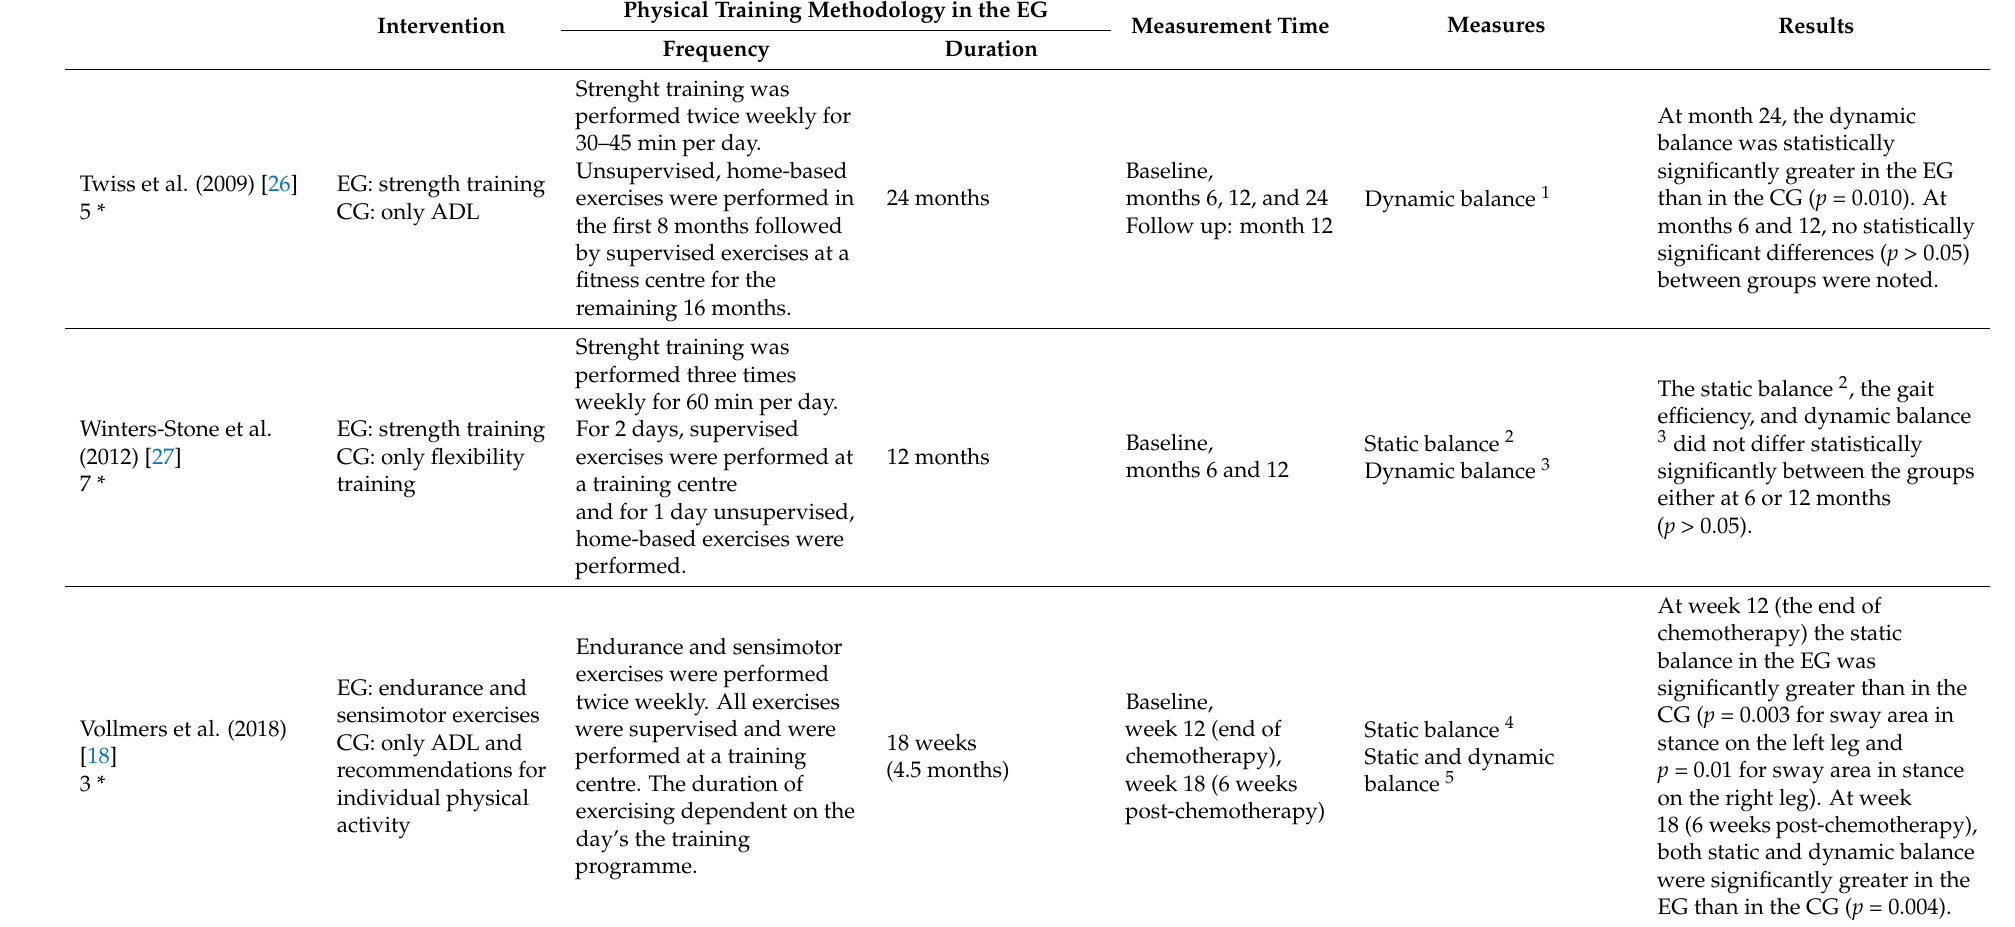
Table 7. Methods of randomized clinical trials and their results regarding the static and dynamic balance of the body. Physical Training Methodology in the EG Intervention